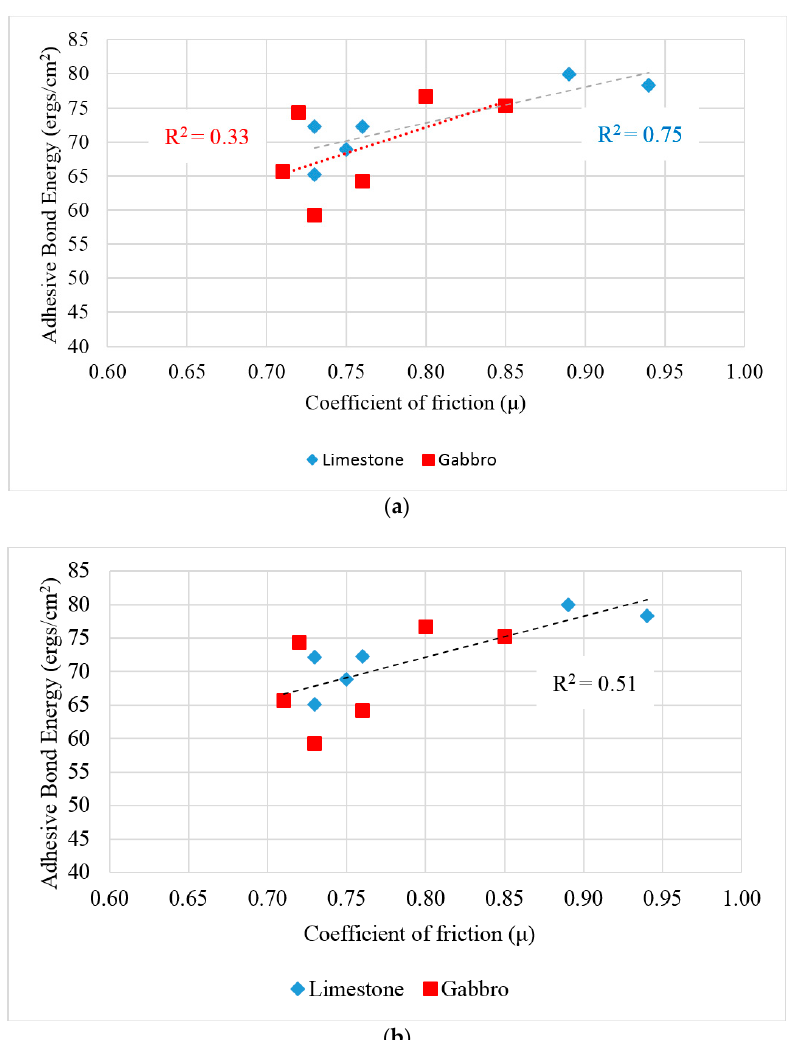
Figure 9. Measured coefficient of friction vs. the adhesive bond energy for ( a ) limestone and gabbro slabs separately ( b ) both gabbro and limestone slabs. slabs separately ( b ) both gabbro and limestone